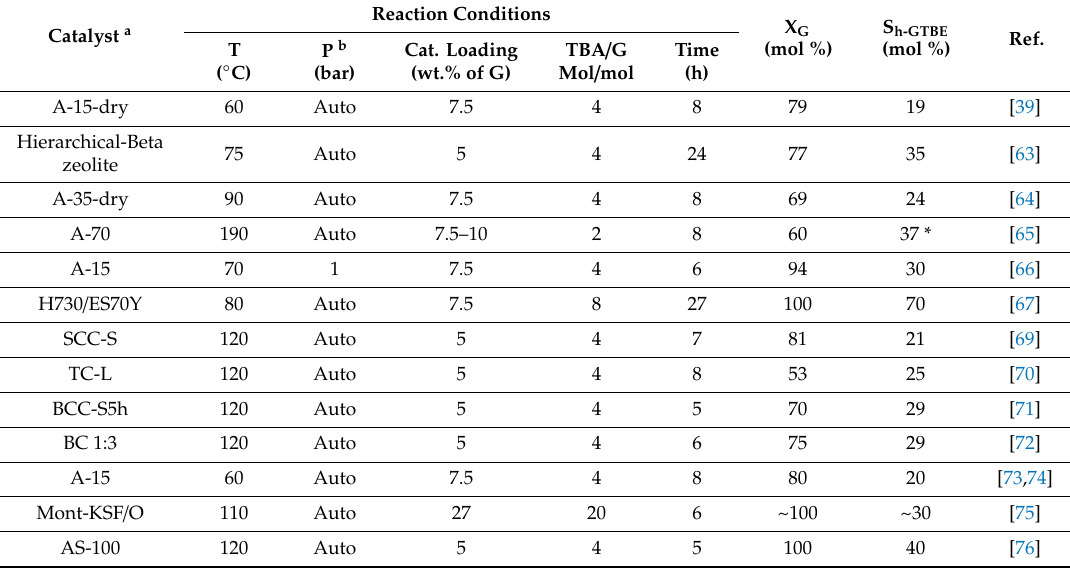
Table 2. Compilation of studies on glycerol etherification with TBA over heterogeneous catalysis. Catalyst